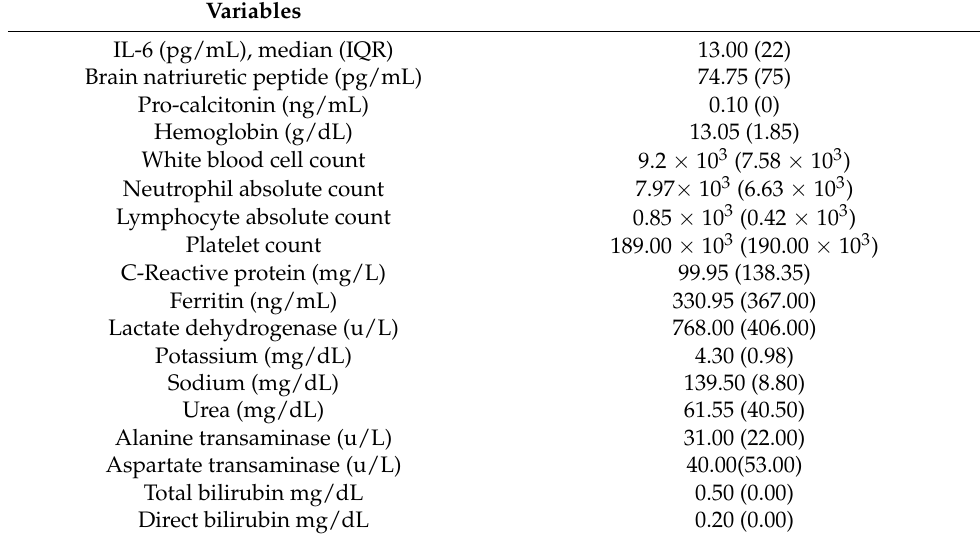
Table 3. Laboratory Investigations and Treatments presented as median and interquartile range ( n =